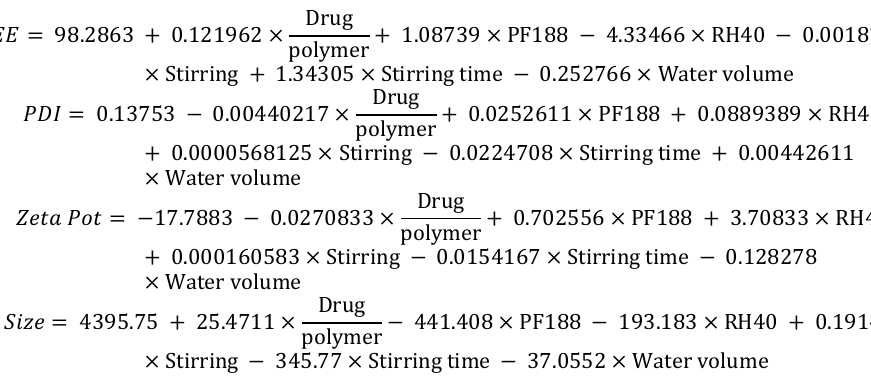
Figure 5. Equations showing the interactions of the different factors in the development of NPs in the screening phase. Table 6. Factors and responses in the screening phase.